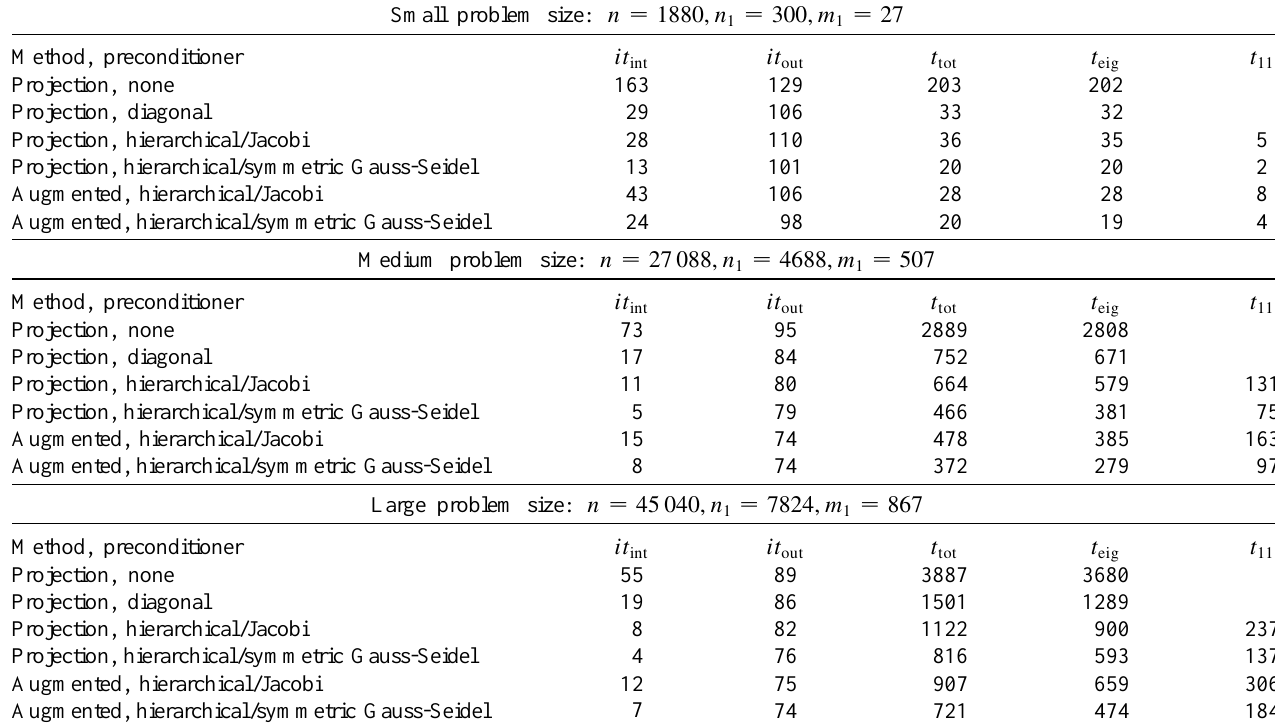
TABLE II. Jacobi-Davidson results for the copper cavity. Times are in